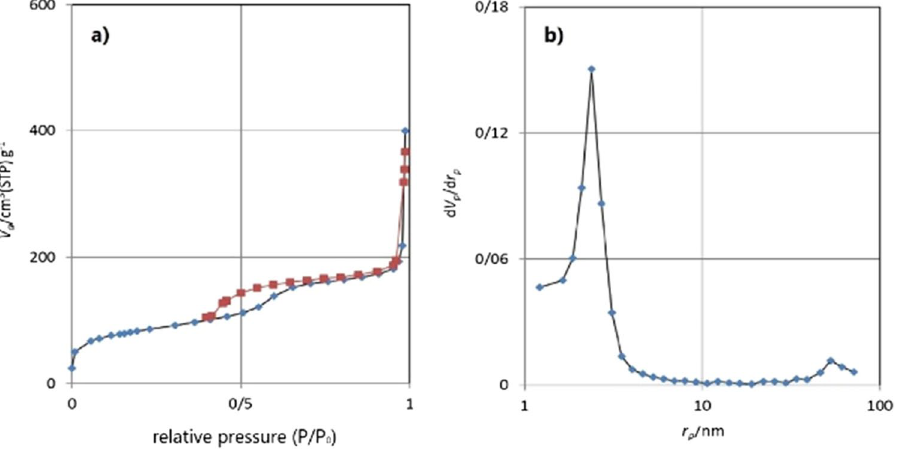
Figure 7. The BET and BJH images of KCC-1@NH 2